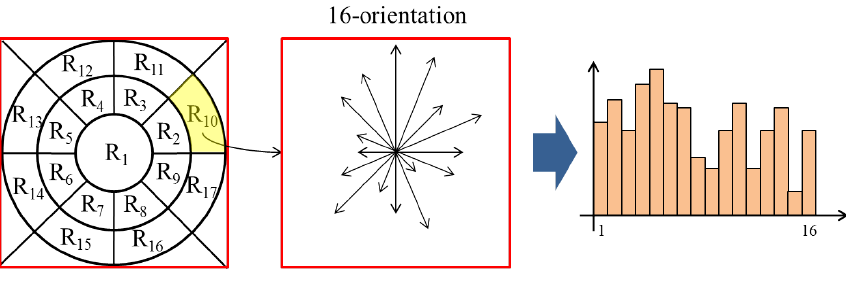
Figure 16. A histogram from one radial subregion.